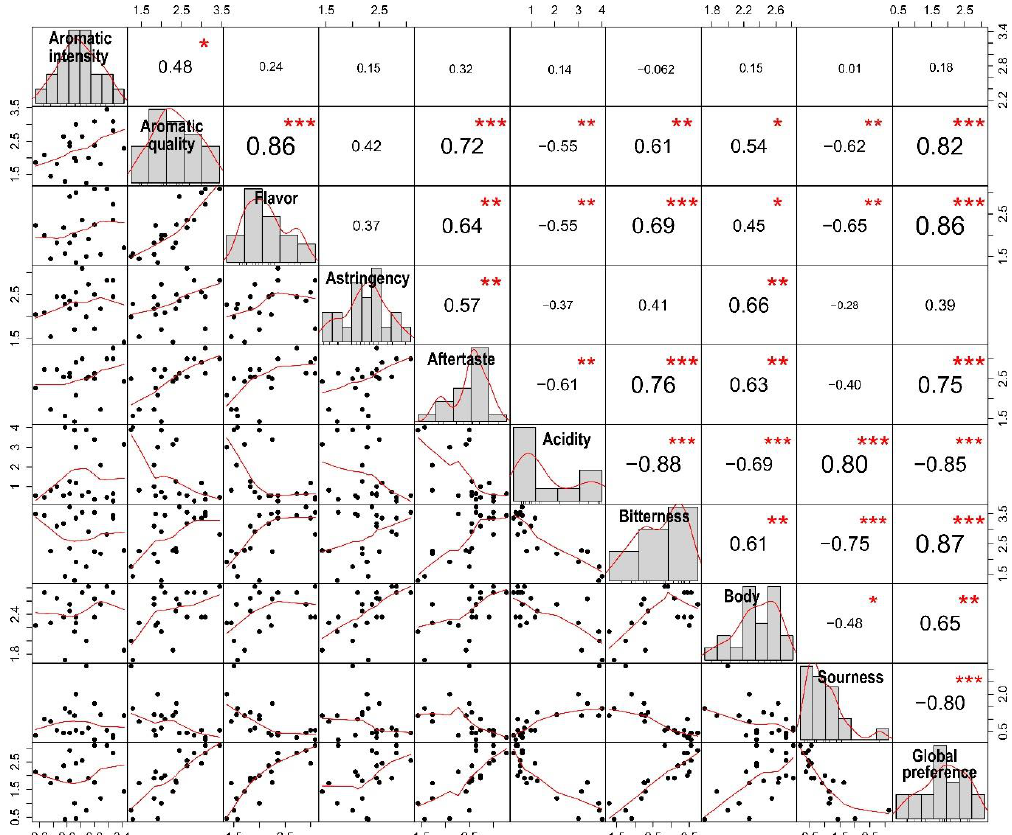
Figure 3. The correlation plot shows histograms and density distribution of cup quality attributes of coffee beverage. The Spearman correlation coefficient (SCC) between sensory traits of the coffee beverage is depicted. Data with statistical significance levels are indicated with asterisks: p -values ≤ 0.05 *, ≤0.01 ** and ≤0.001 ***.